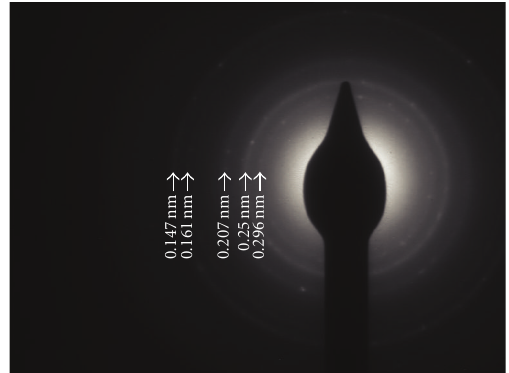
Figure 4: SAED analysis of sample 02, revealing main di ff raction rings of